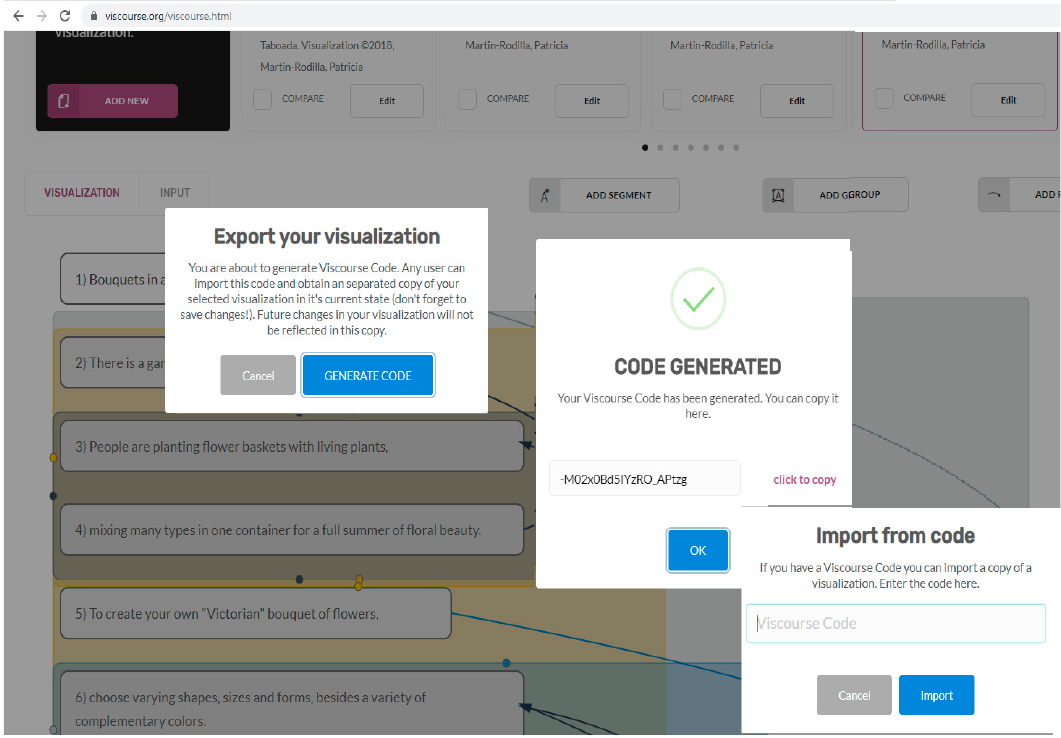
Figure 5. Viscourse code, a black-box mechanism for sharing and reusing textual analysis information between users.